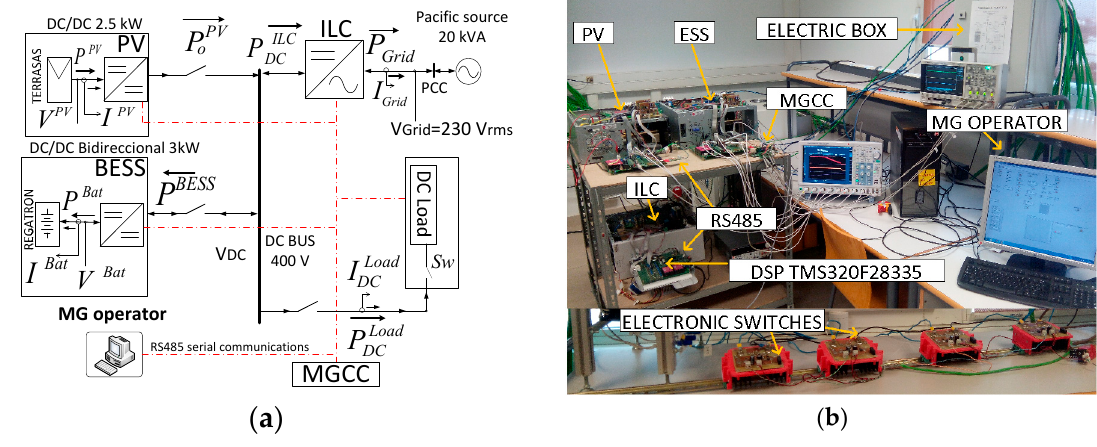
Figure 11. Experimental DC microgrid: ( a ) Block diagram of the experimental DC microgrid ( b ) Picture of the power converters operating in the experimental DC microgrid.